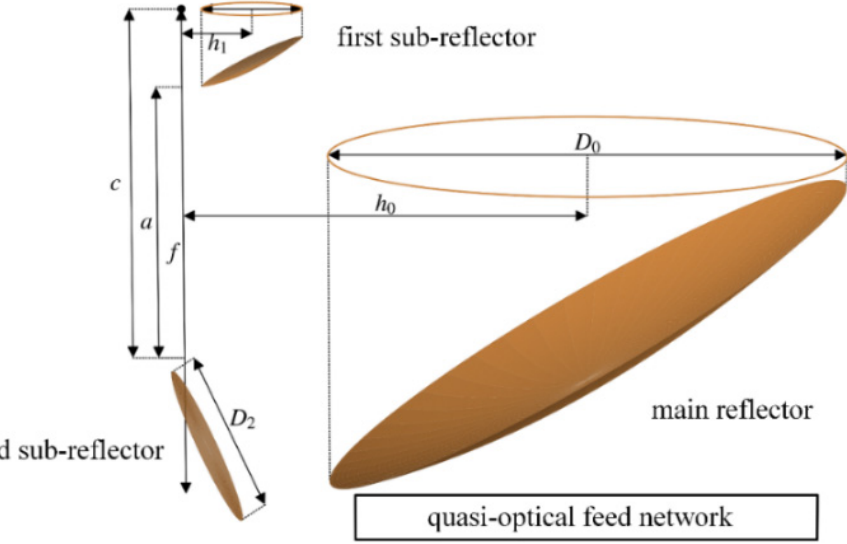
Figure 1. The geometry of the GEO microwave antenna that was used in this study.